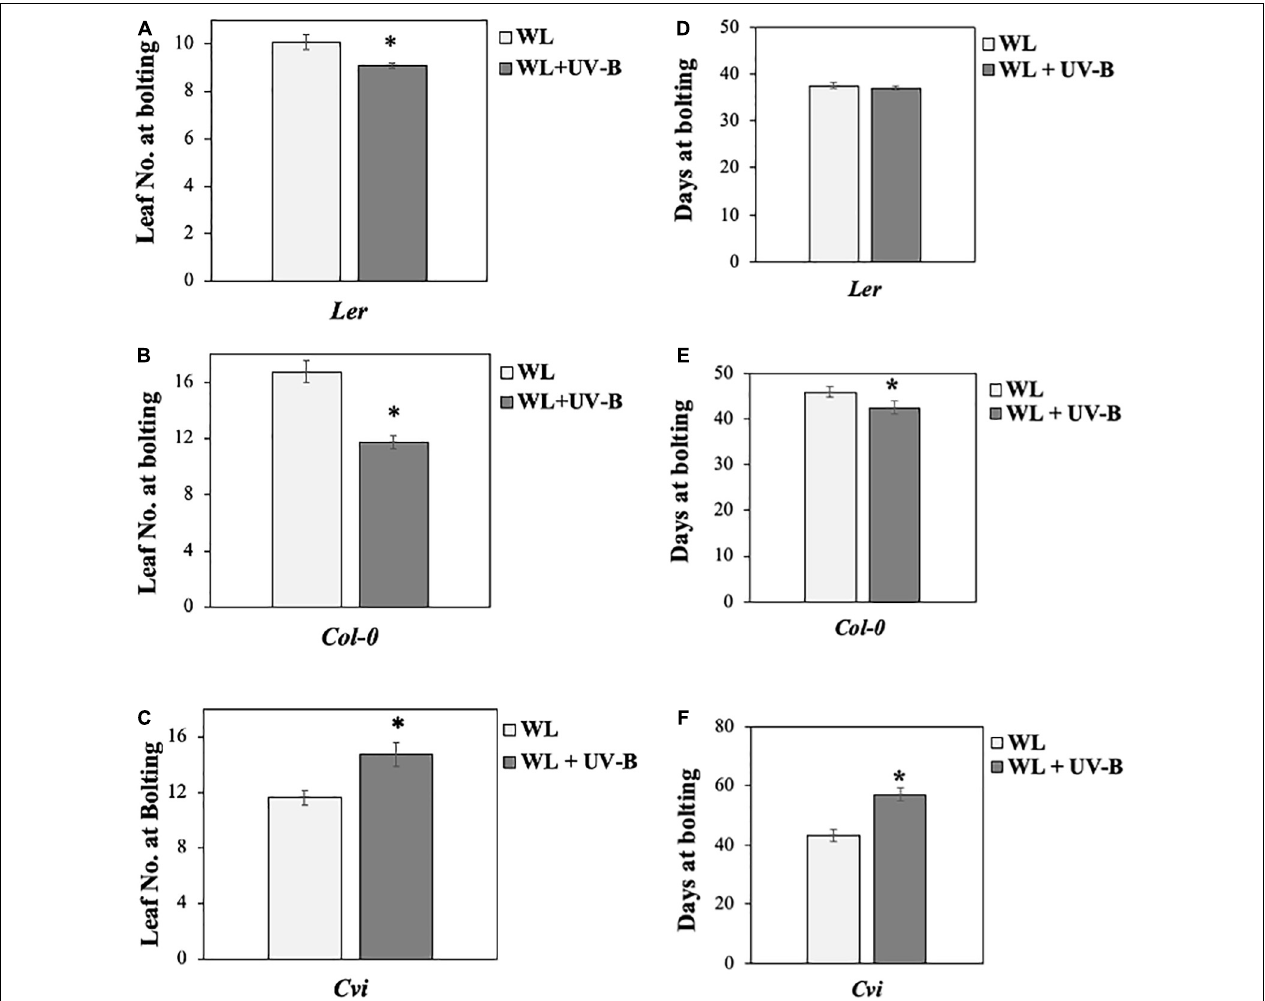
FIGURE 1 | UV-B induces early flowering in Col-0 and Ler but delays it in Cvi . (A–C) Flowering times (as measured by rosette leaf number) of Col-0 (A) , Ler (B) , and Cvi (C) ecotypes grown under a LD photoperiod in WL (50 µ mol m − 2 s − 1 ) or WL supplemented with UV-B (0.5 µ mol m − 2 s − 1 ). Data are represented as mean ± SEM ( n ≥ 15 plants recorded) and an asterisk ( ∗ ) indicates statistically significant differences ( P < 0.05) between means. (D–F) Flowering times (as measured by the number of days prior to bolting) of Col-0 (D) , Ler (E) , and Cvi (F) ecotypes grown under a LD photoperiod in WL (50 µ mol m − 2 s − 1 ) or WL supplemented with UV-B (0.5 µ mol m − 2 s − 1 ). Data are represented as mean ± SEM ( n ≥ 15 plants recorded) and an asterisk (*) indicates statistically significant differences ( P < 0.05) between means. Data are representative of three biological repeats including all genotypes represented above, a minimum number of 15 plants was assayed per genotype per